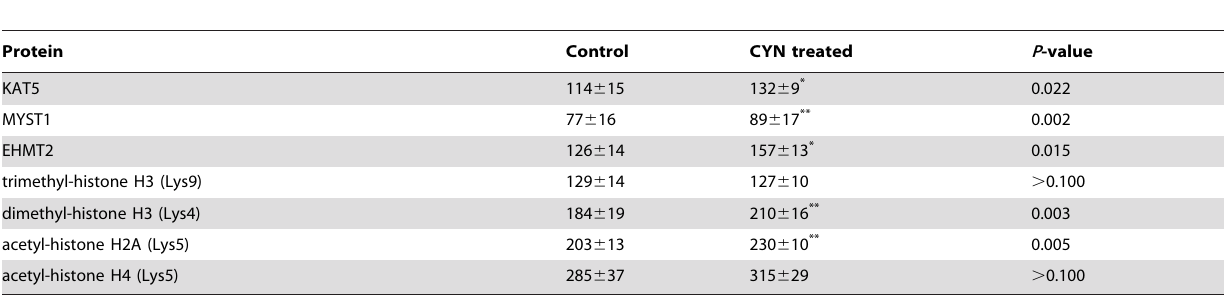
Table 2. Levels of KAT5, MYST1, EHMT2, trimethyl-histone H3 (Lys9), dimethyl-histone H3 (Lys4), acetyl-histone H2A (Lys5) and acetyl-histone H4 (Lys5) in differentiated Caco-2 cells after 24 hrs exposure to 1.6 m M